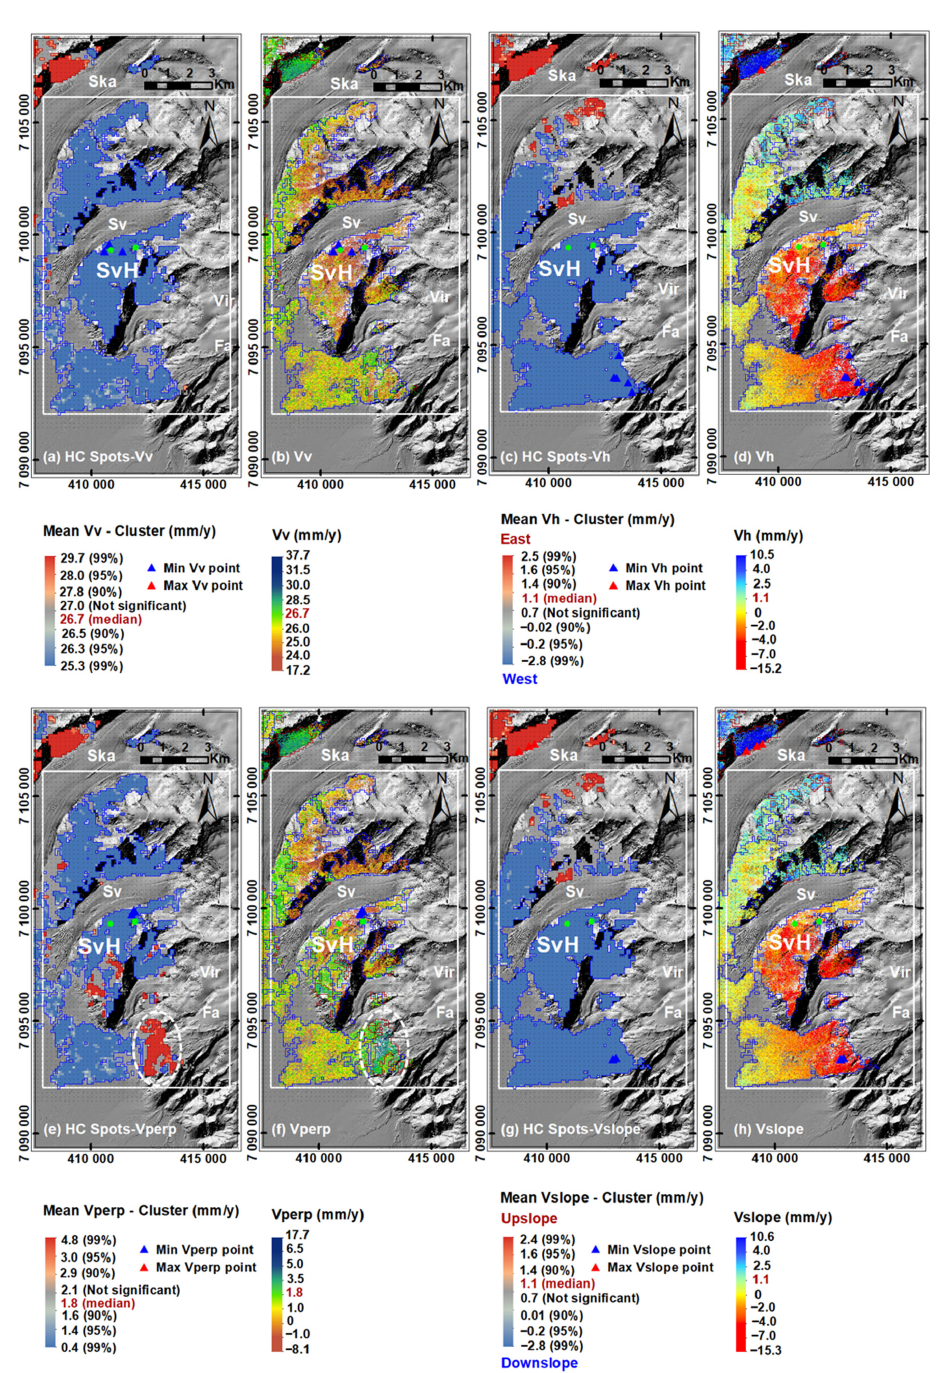
Figure 10. Visualisation of pairwise Hot-Spot and Cold-Spot clusters coupled with their one-dimensional PS-based deformation estimates of the terrain slopes around Svínafellsjökull: ( a , b ) Hot and Cold Spots of V v and V v ; ( c , d ) Hot and Cold Spots of V h and V h ; ( e , f ) Hot and Cold Spots of V perp and V perp ; and ( g , h ) Hot and Cold Spots of V slope and V slope . The red and blue triangles represent